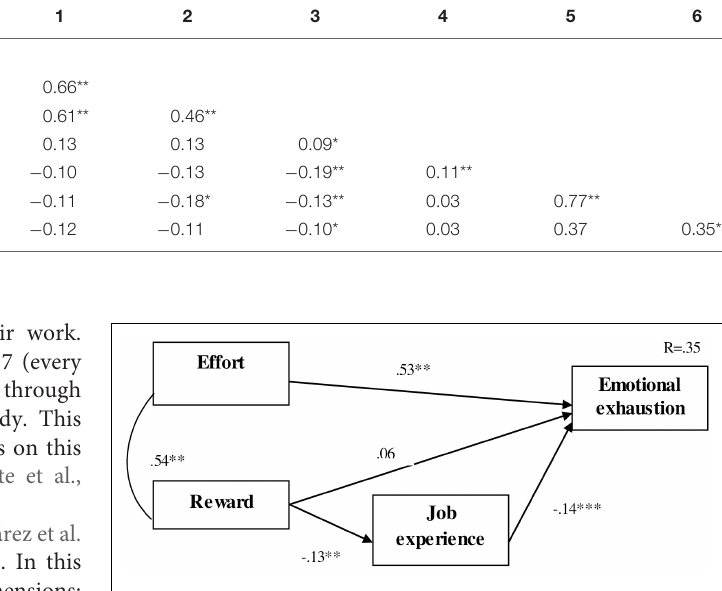
FIGURE 1 | Effort-reward model. ** p < 0.01; *** p <